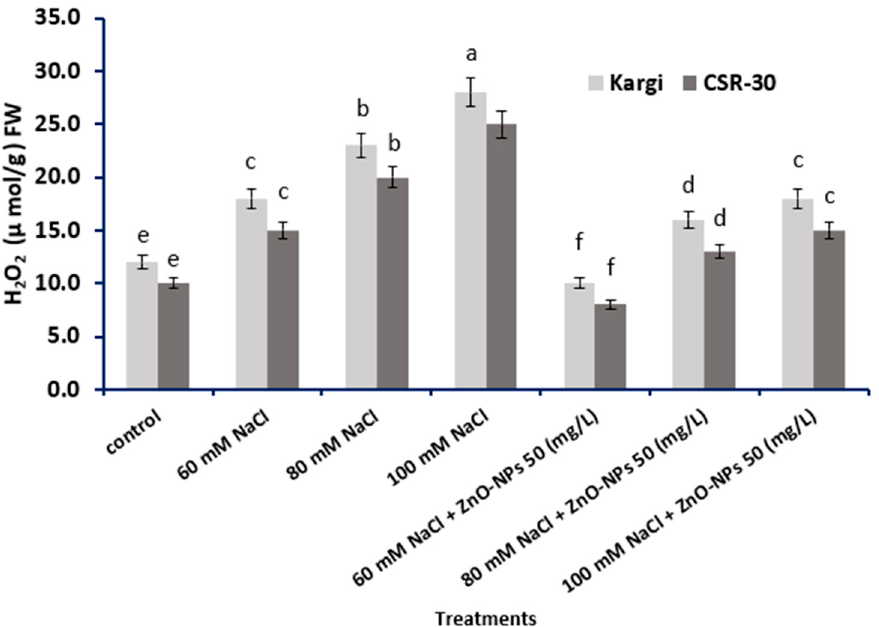
Figure 3. Effect of ZnO-NPs on H 2 O 2 content in leaves of Kargi and CSR 30 Oryza sativa genotype in control and under saline conditions. Values are means of three replicates. Different small alphabets (a–f) indicate a statistically significant difference between treatments compared with control. Error bars indicate the least considerable value (LSD) at p ≤ 0.01 among the treatments.